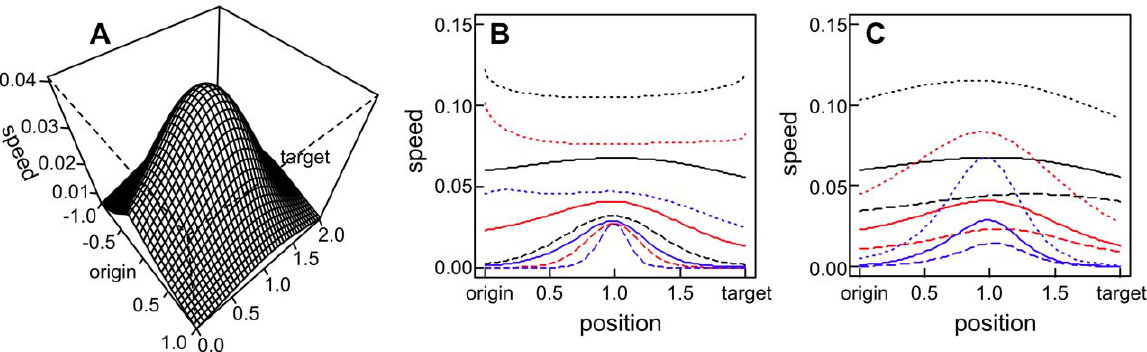
Figure 2. The value of a ‘‘stepping stone’’ of habitat as a function of its location. given a source patch at (0, 0) and target patch at (0, 2). Speed is defined as the probability of colonizing the target at all (not going extinct) divided by the mean time until the target is colonized. ( a ) Speed vs. location of the stepping stone shown in two dimensions (x, y) with one parameter set: colonization parameters a =1, g =1 and extinction probability m =0.2. ( b ) Speed vs. location of the stepping stone shown in one dimension, along the straight line between the source patch and the target patch, and the effect of varying the colonization kernel a =[1,2,4] shown with [black,red,blue] and g =[0.5,1,2] shown with [dotted,plain,dashed] lines where m =0.2. ( c ) the effect of varying the extinction probability m =[0.05,0.2,0.4] shown with [dotted,plain,dashed] lines, with a =[1,2,4] shown with [black,red,blue] and g =1.